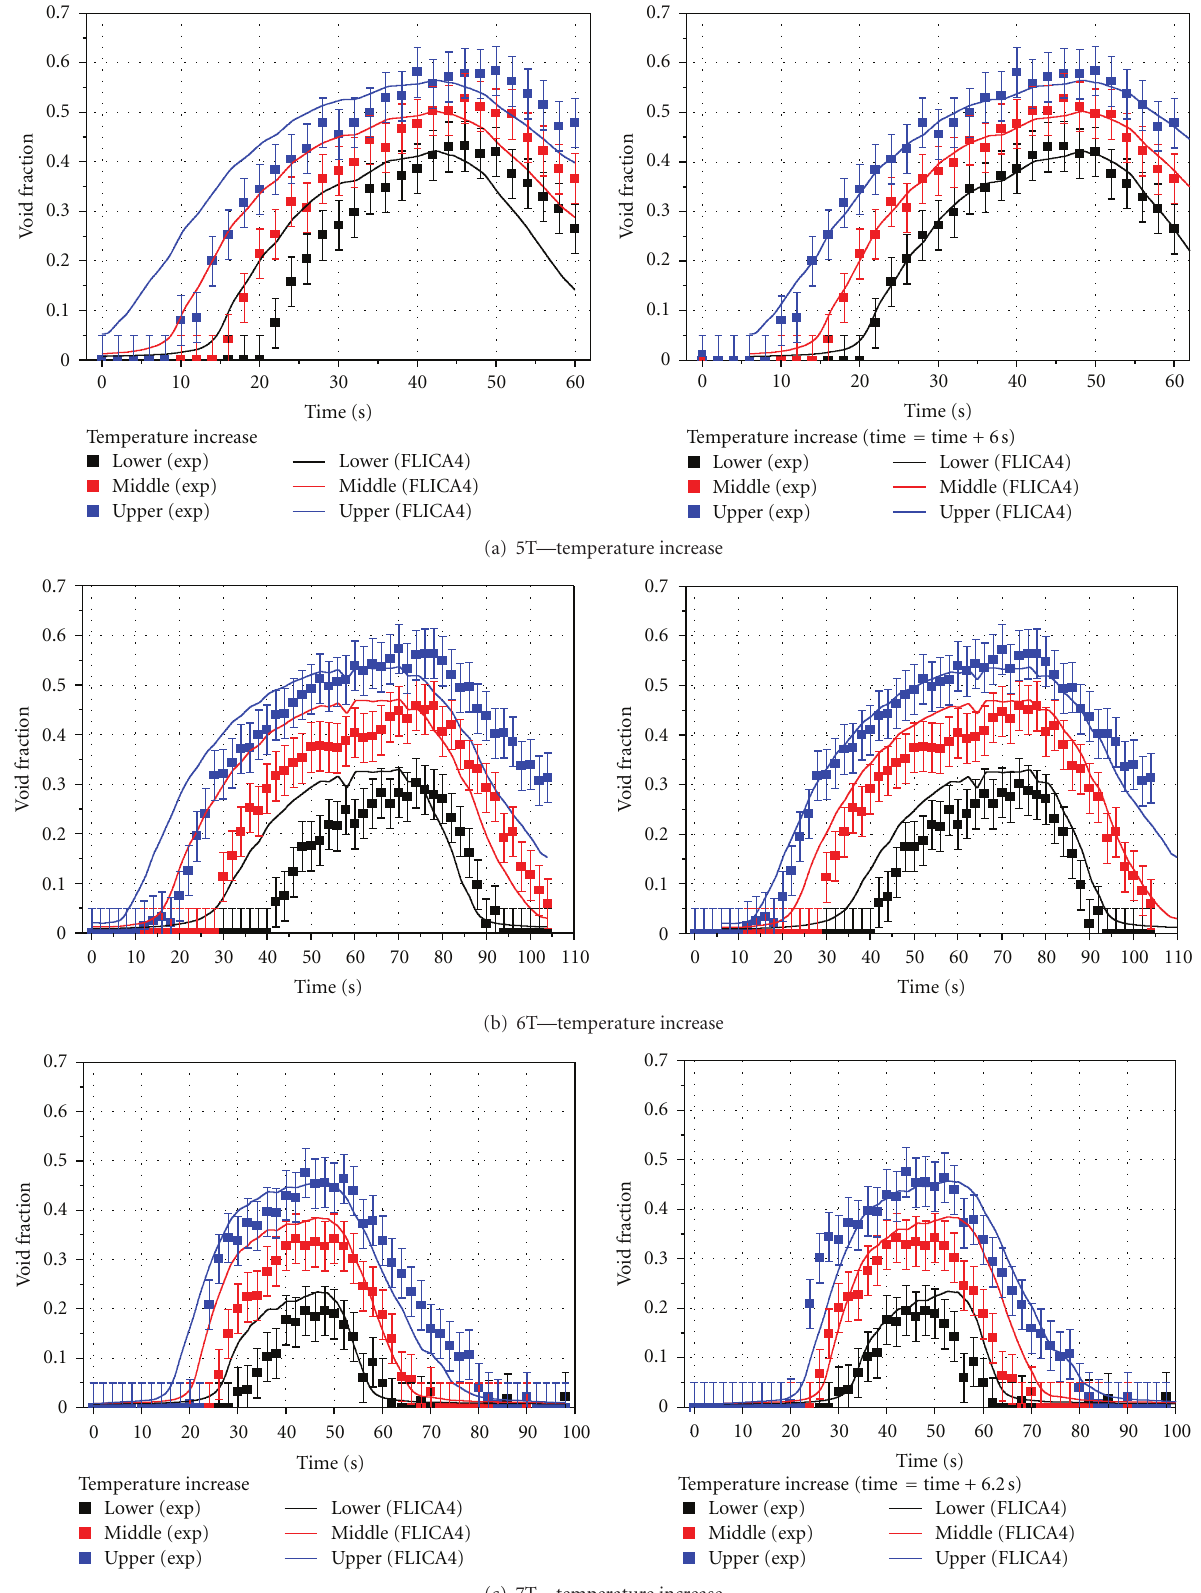
Figure 17: Axial void fraction with original and modified